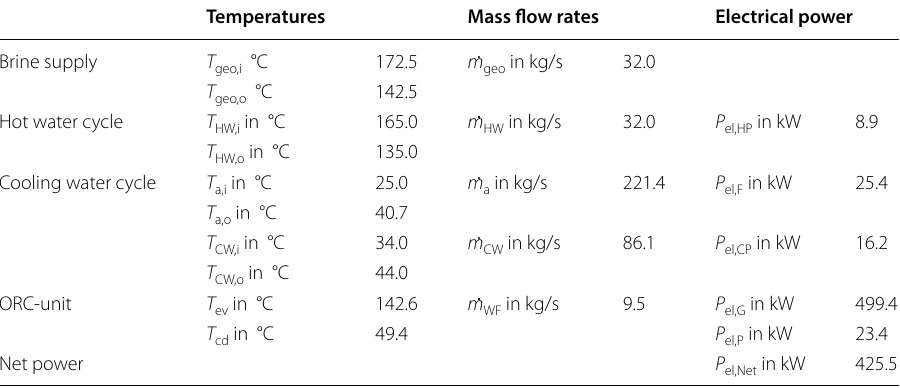
Table 2 Process design data and design electrical data of the demonstration